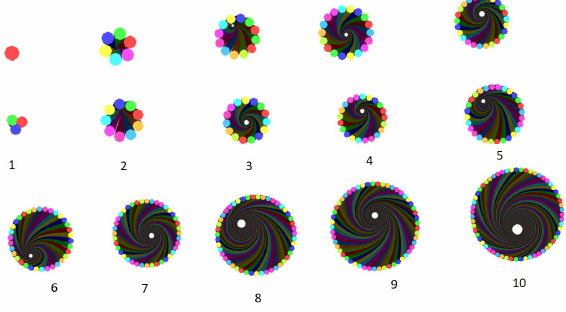
Figure 16. Cross sections of different layers (1–10) of the yarn model.